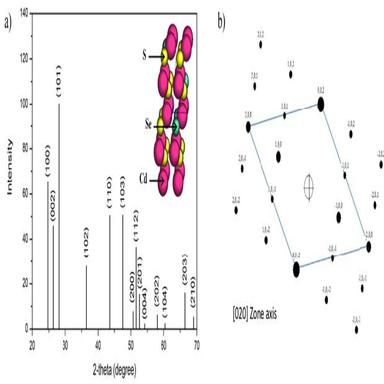
(a) The XRD pattern with simulation of 3D latice structure; (b) the simulated SAED pattern of CdSo,Sep. by CaRine3.1 program.